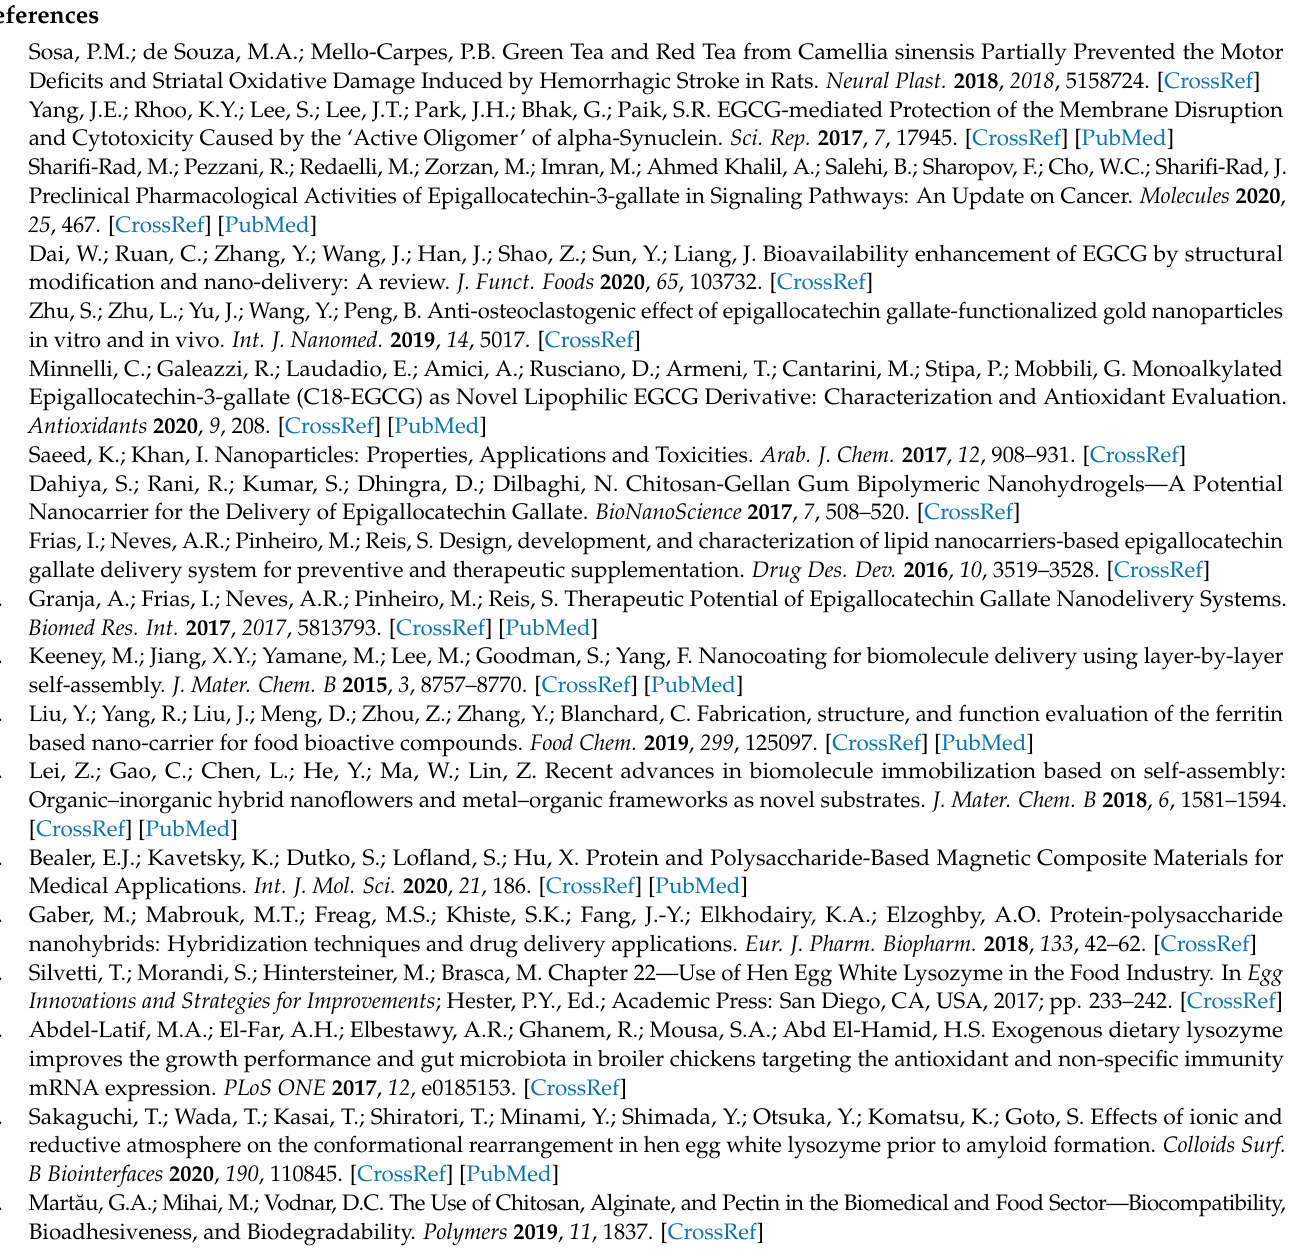
ture, Table S3: Effect of EGCG/lysozyme molar ratio on ζ -potential and PDI of lysozyme/pectin nanoparticles after 24 h storage at room